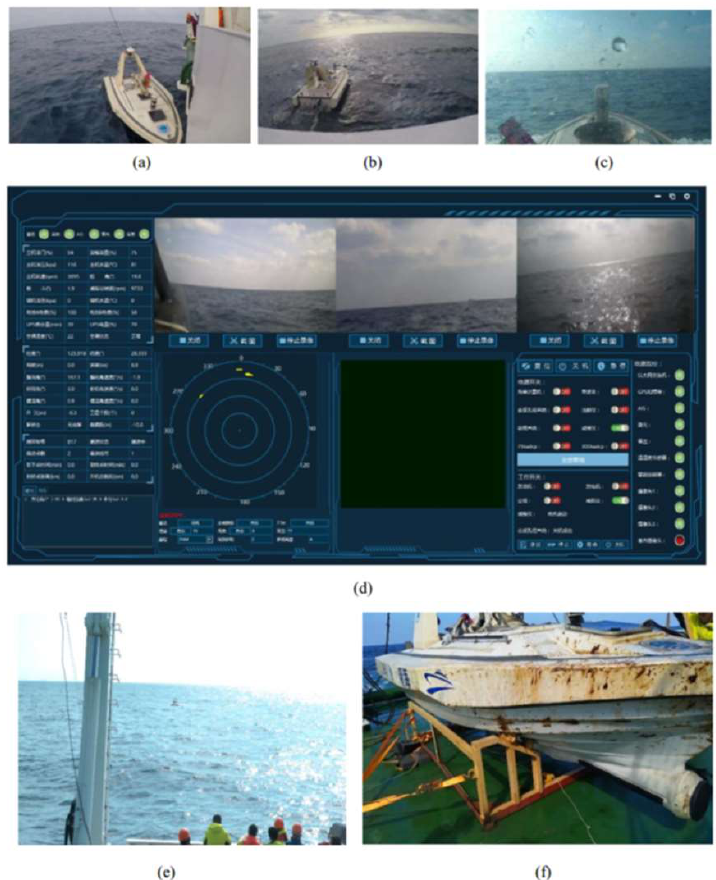
Figure 14. The USV in the mission: ( a ) The USV was being deployed in the mission area. ( b ) The USV was deployed successfully and sailed to the target. ( c ) The USV was scanning. ( d ) Display control interface on the mothership. ( e ) The USV was returning to the mothership. ( f ) The surface of the hull after the mission was completed.